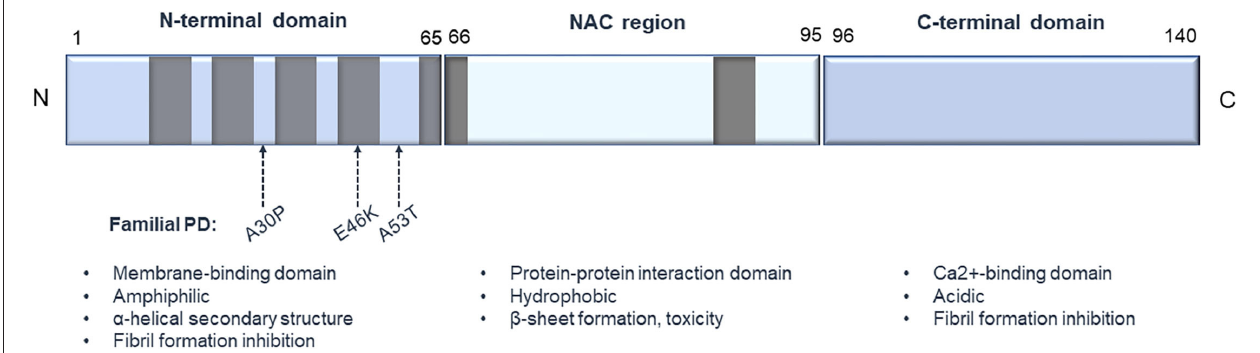
FIGURE 1 | Structure of human α -synuclein. The protein consists of 3 main structural elements: (1) an amphiphilic N-terminus characterized by KTKEGV conserved motifs, important for binding to membranes; (2) an internal hydrophobic NAC domain that is involved in α -syn aggregation; and (3) an acidic C-terminus, which is important for Ca 2 + binding. Gray boxes represent the KTKEGV motifs, and the arrows designate some of the common point mutations that are connected to PD